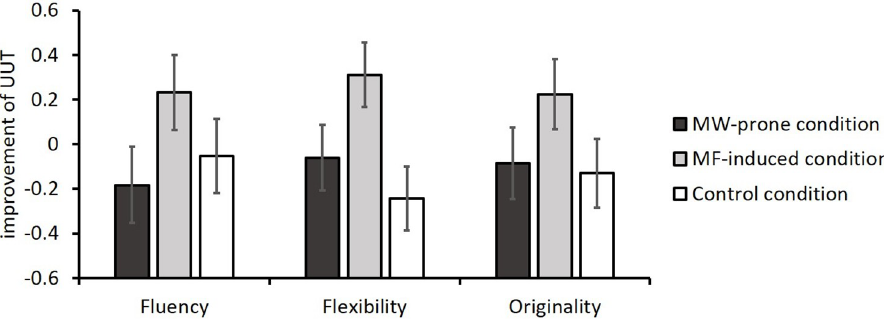
Fig 2. The three aspects of improvement of UUT for participants in the MW-prone condition (N = 29), MF- induced condition (N = 30), and control condition (N = 31).